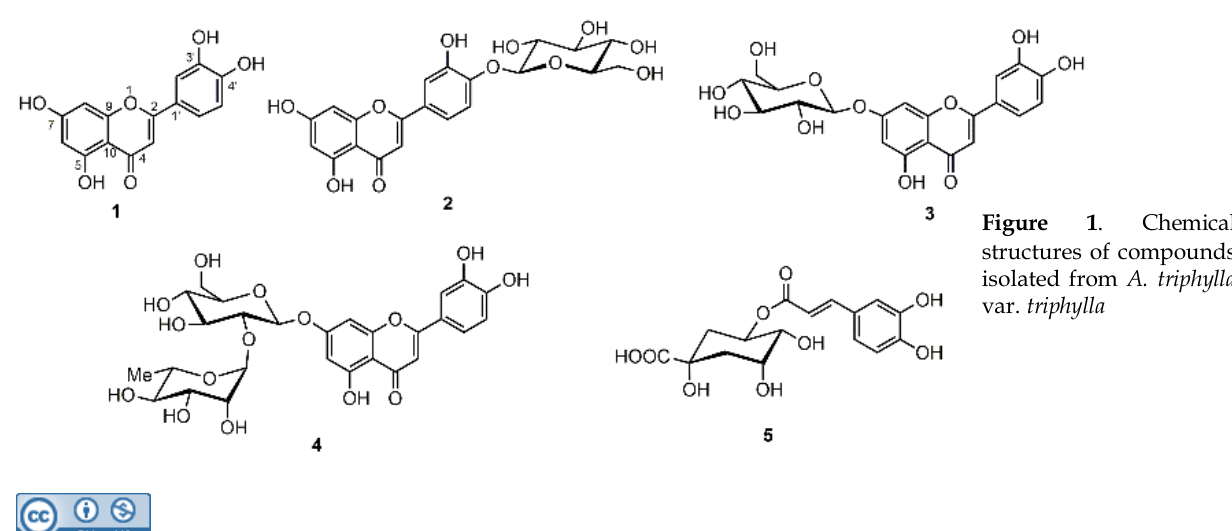
Figure 1 . Chemical structures of compounds isolated from A. triphylla var.